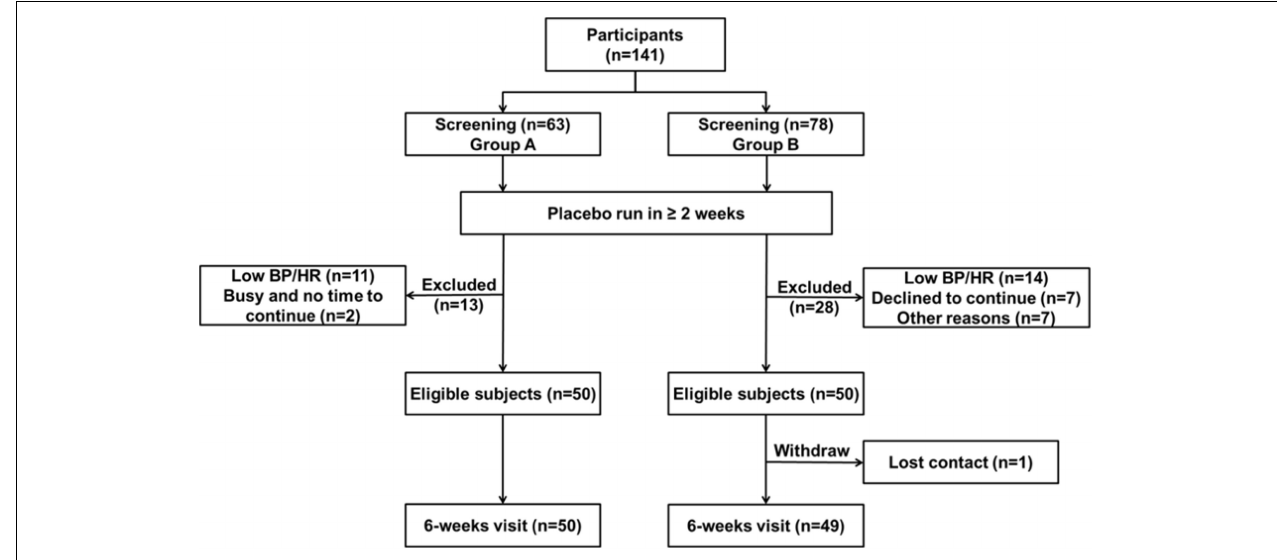
FIGURE 1 | Consort diagram of the